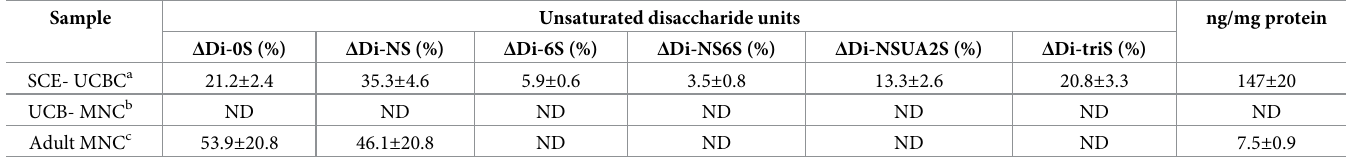
a stem-cell-enriched umbilical cord blood cells (n = 3), b mononuclear cells derived from rat umbilical cord blood(collected from 70 pups), c mononuclear cells derived from peripheral blood of adult rat (n =